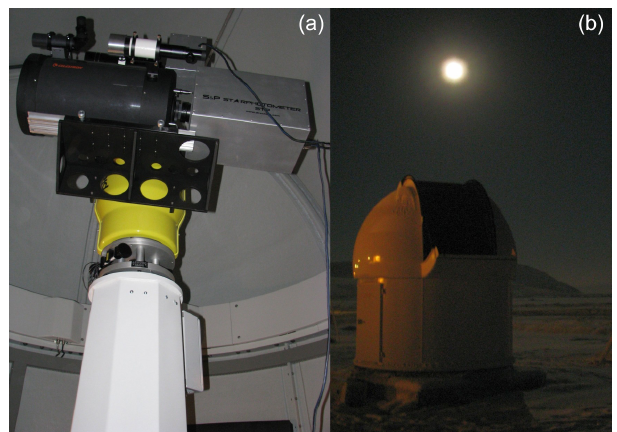
Figure 1. The SPST09 starphotometer and Celestron C11 telescope installed on the AZA-2000 mount, inside the Baader dome at Eu- reka (a) . Outside view of the dome at Eureka, during a starphotome- ter observation (b) .